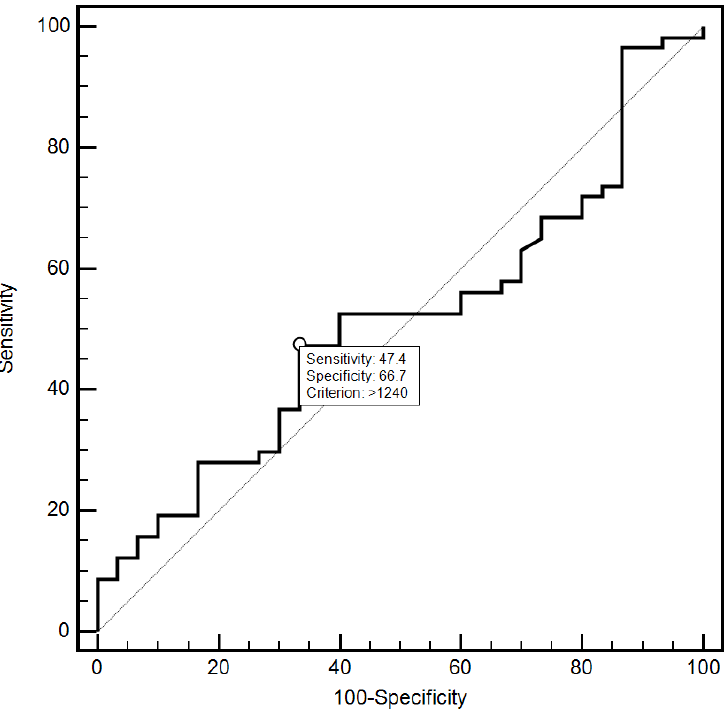
Figure 12. Assessment of the diagnostic usefulness of the MMP-9 (ng/mL) concentration determina- tion in the peripheral blood serum in the early detection of preterm labor using the ROC